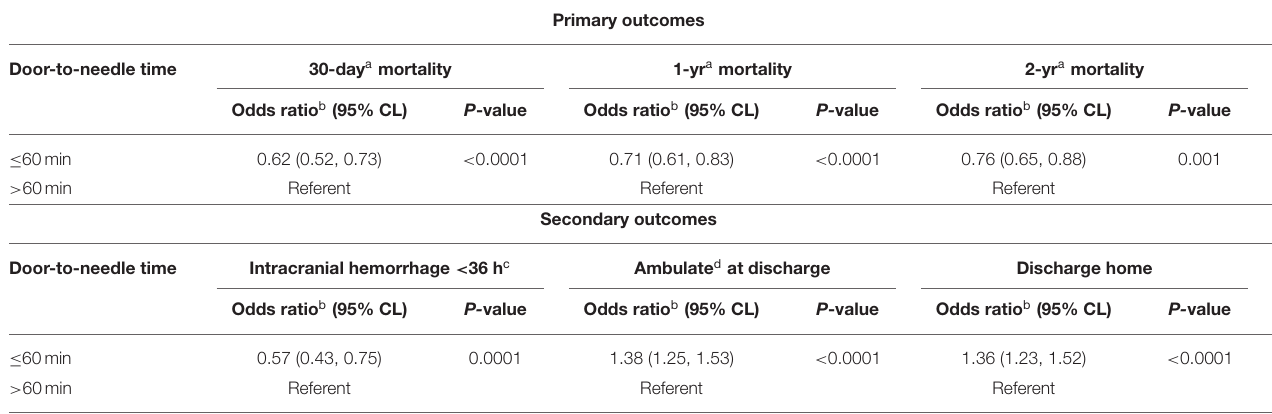
TABLE 3 | Relative risk of mortality among ischemic stroke patients treated with intravenous alteplase and secondary outcomes by DTN. Primary outcomes